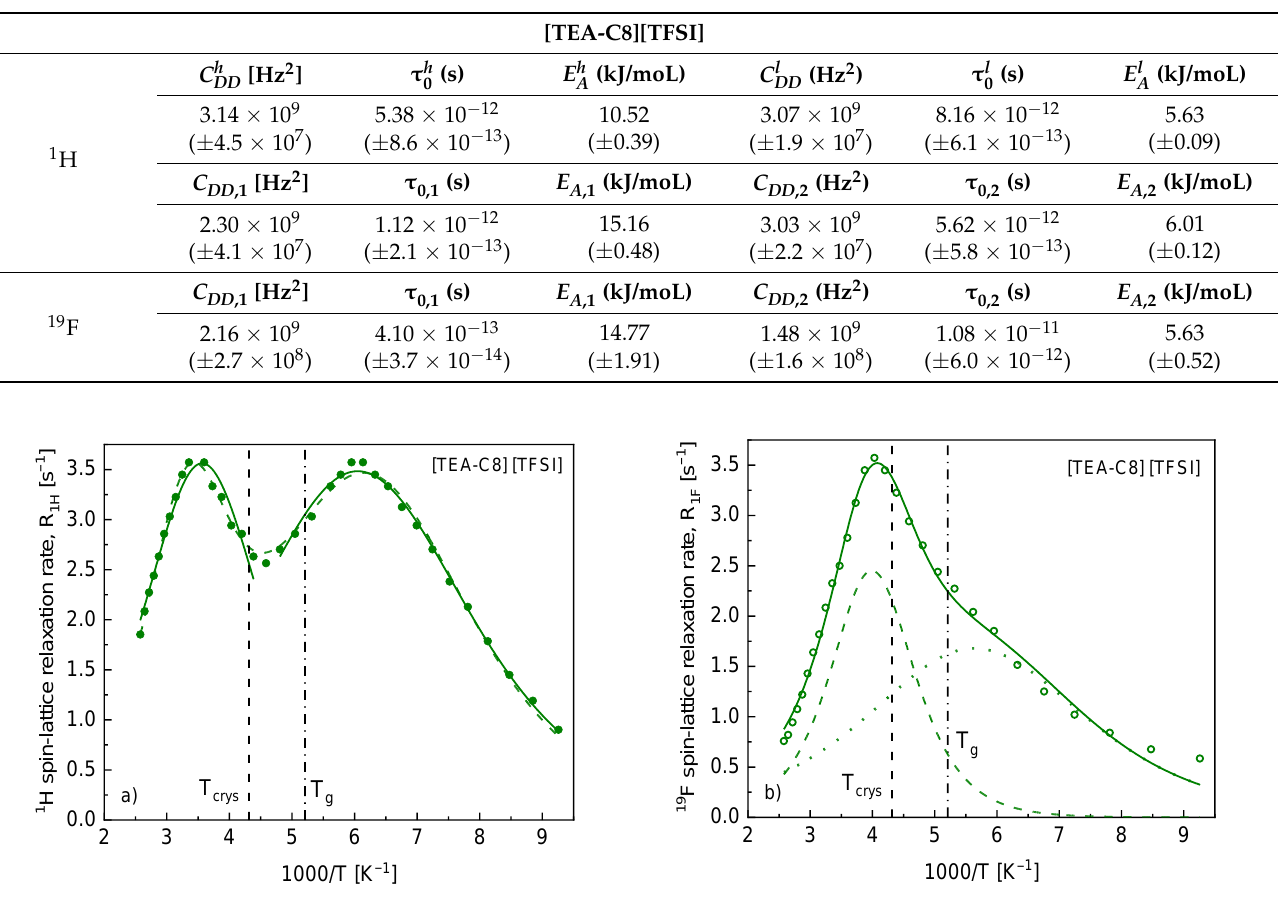
Figure 3. 1 H ( a ) and 19 F ( b ) spin-lattice relaxation rates versus reciprocal temperature for [TEA- C8][TFSI]. Solid and dashed green lines — fits with parameters collected in Table 2, dashed line in ( b ) — relaxation contribution related to the parameters 𝐶 𝐷𝐷,1 , 𝜏 0,1 , 𝐸 𝐴,1 , dotted line in ( b ) — relaxation contribution related to the parameters 𝐶 𝐷𝐷,2 , 𝜏 0,2 , 𝐸 𝐴,2 , vertical lines indicate phase transition tem- peratures ( 𝑇 𝑐𝑟𝑦𝑠 = 231.83 K, the glass transition temperature 𝑇 𝑔 = 192.00 K [26]).